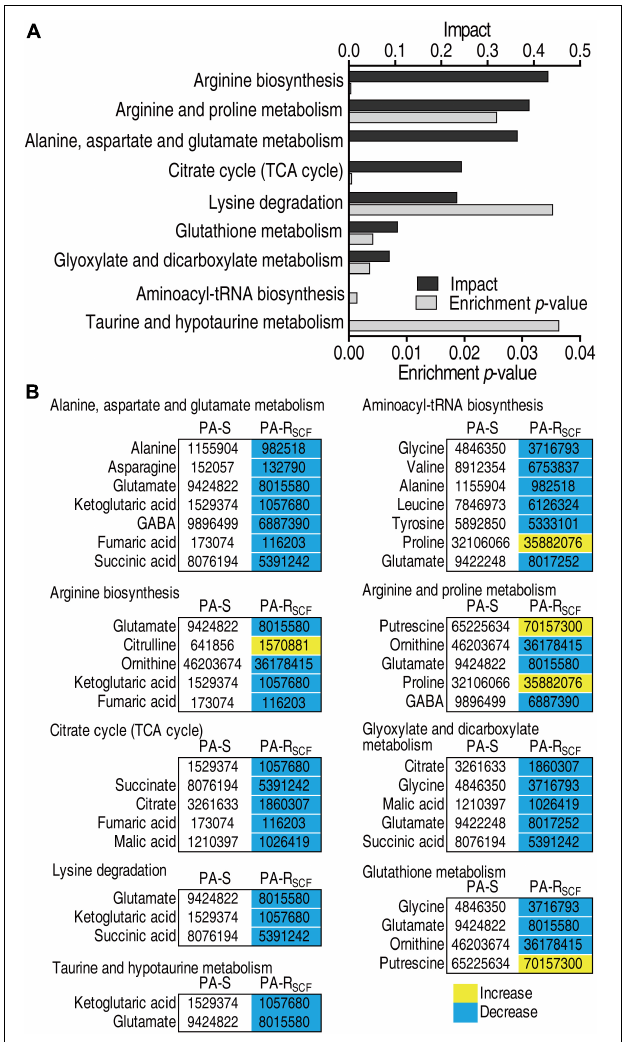
FIGURE 3 | Enrichment of metabolic pathways in PA-R SCF . (A) Pathway enrichment of differential abundance of metabolites in PA-S and PA-R SCF . Significantly enriched pathways are selected to plot. p < 0.05. (B) Integrated analysis of pathways enriched by significantly associated metabolites. Yellow color and blue color indicate increased and decreased metabolites,